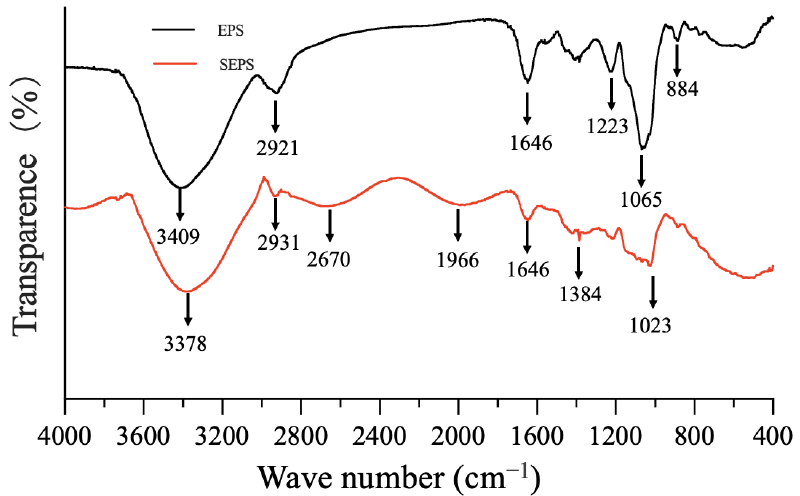
Figure 11. The FTIR of EPS and SEPS by B. subtilis T5.